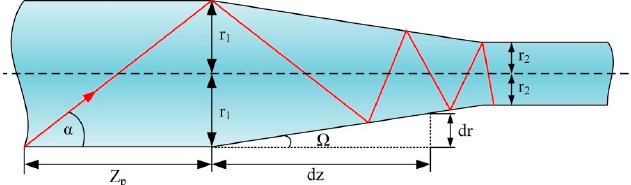
Figure 4. Scheme of ray propagation in a multimode fiber, adapted from [18,41].